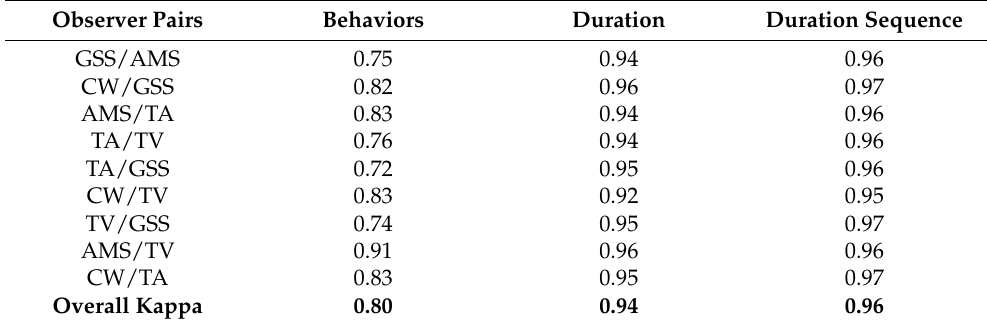
Table A1. Pairwise average Cohen’s kappa for observer pairs. The first column includes the average kappa for each observer pair across all breed observations for the behaviors exhibited, sequence of behaviors, and number of bouts calculated as a combined kappa (labeled ‘Behaviors’). Kappa for duration and duration sequence are also reported for each observer pair. Cohen’s kappa averaged across all observer pairs for each overall kappa (behaviors, duration, and duration sequence) are noted at the bottom of the column.